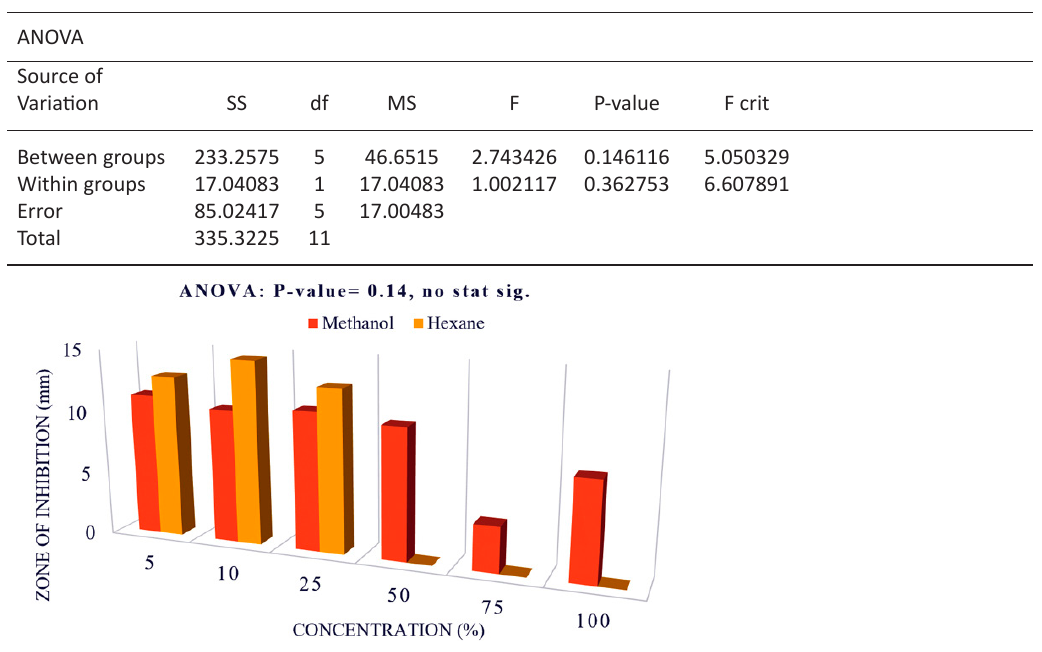
Table 7. Results obtained from the ANOVA analysis for methanol and hexane extracts for C. cinereum at 100%, 75%, 50%, 25%, 10% and 5% concentration against P. aeruginosa